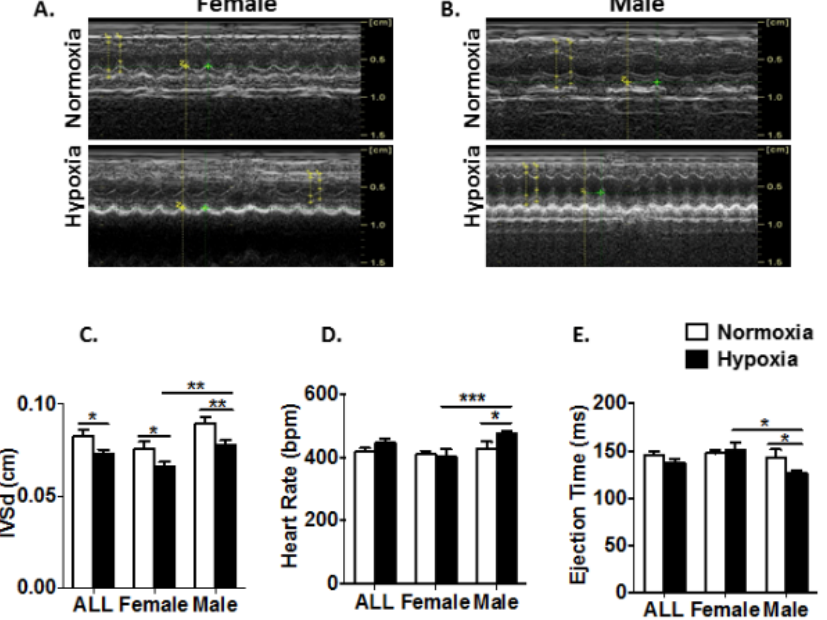
Figure 3. Prenatal hypoxia impairs heart function in four-week-old offspring with a gender-related difference. Mice were studied by echocardiography at four weeks old using an M-mode recording of the left ventricular (LV) at the level of the mitral valve in the parasternal view. ( A ) Representative echocardiographic images of M-model measurement of LV structures for females under the indicated conditions. ( B ) Representative echocardiographic images of M-model measurement of LV structures for males under the indicated conditions. ( C ) Interventricular septum thickness at diastole (IVSd) for all mice under the indicated conditions. Data are presented as the mean ± SEM (n ALL-Normoxia = 8 and n ALL-Hypoxia = 12; n Female-Normoxia = 4 and n Female-Hypoxia = 5; n Male-Normoxia = 4 and n Female-Hypoxia